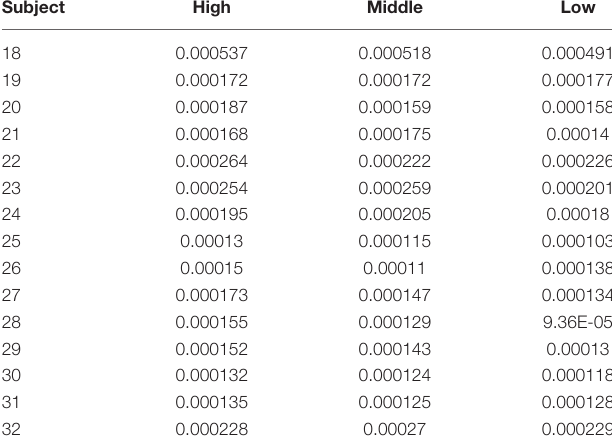
TABLE 1 | Fractal index data for every experimental subject.